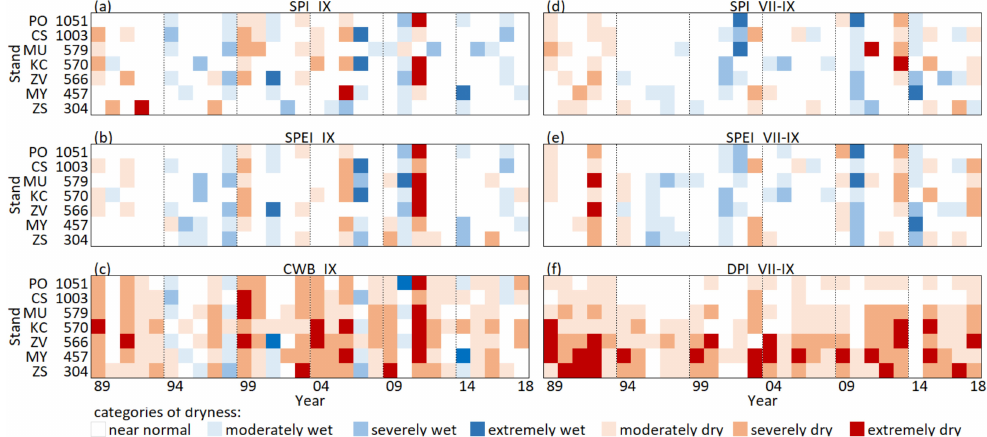
Figure 3. Meteorological drought of one month (September) and three months (July to September) prior to onset of leaf colouring indicated using the indices: standardized precipitation index (SPI IX ) ( a ), standardized precipitation evapotranspiration index (SPEI IX ) ( b ), climatic water balance (CWB IX ) ( c ), SPI VII–IX ( d ), SPEI VII–IX , ( e ) and dry periods index DPI VII–IX ( f ) for each stand over period between 1989–2018. In each mosaic, the stands are ordered with increasing altitude from the bottom to the top.